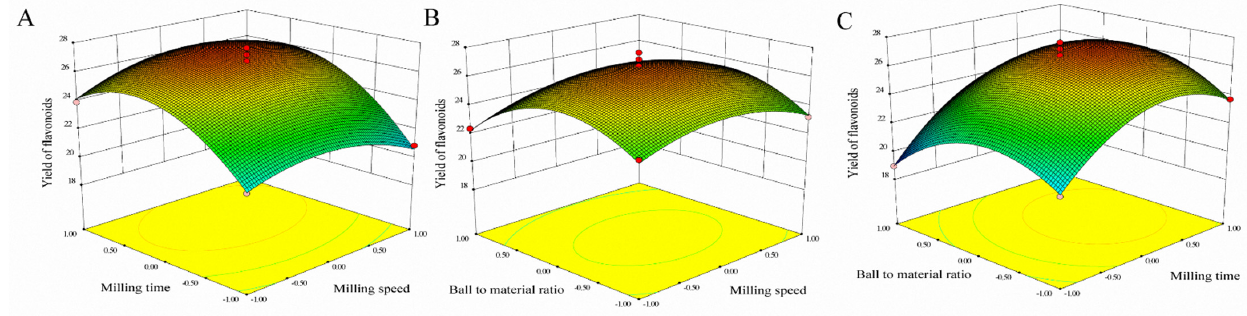
Figure 2. Response surfaces representations for MCAE operating parameters. ( A ) Varying milling speed and milling time; ( B ) Varying ball-to-material and milling speed; ( C ) Varying ball-to-material and milling time.